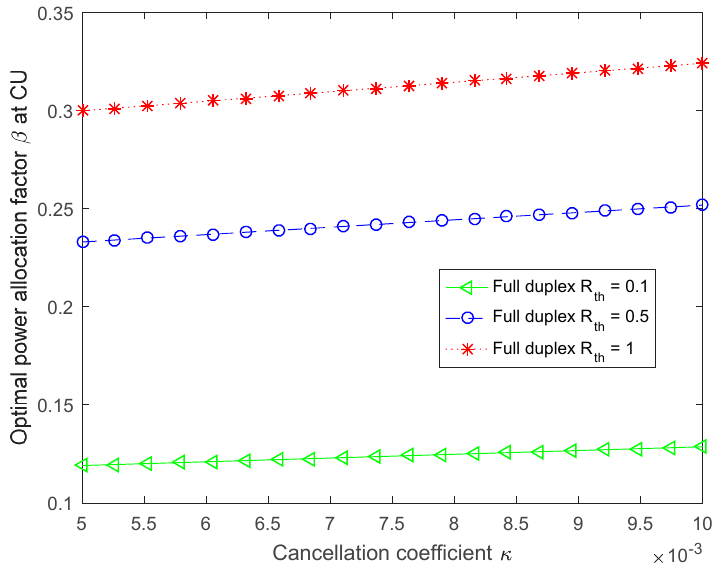
Figure 5. The optimal power allocation factor at CU versus cancellation coefficient. The curves of the optimal allocation factor